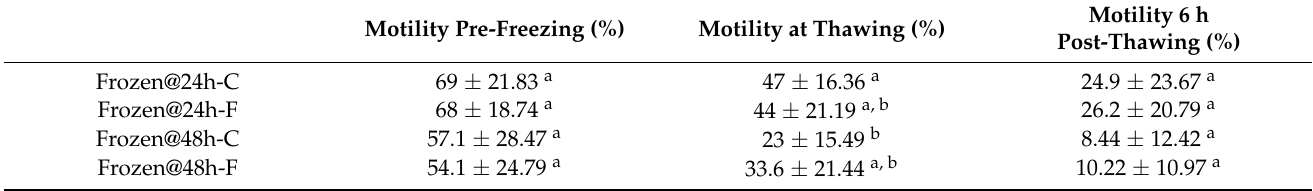
Table 5. Subjective motility of ejaculated canine spermatozoa after dilution with chilling (C) or freezing extender 1 (F), chilling and storage for 24 or 48 h in a transport box, and Uppsala freezing. Motility 6 h Motility Pre-Freezing (%) Motility at Thawing (%) Post-Thawing (%) Frozen@24h-C 69 ± 21.83 a 47 ± 16.36 a 24.9 ± 23.67 a Frozen@24h-F 68 ± 18.74 a 44 ± 21.19 a, b 26.2 ± 20.79 a Frozen@48h-C 57.1 ± 28.47 a 8.44 ± 12.42 a Frozen@48h-F 54.1 ± 24.79 a 33.6 ± 21.44 a, b 10.22 ± 10.97 a a,b Indicate significant differences within columns ( p < 0.05).